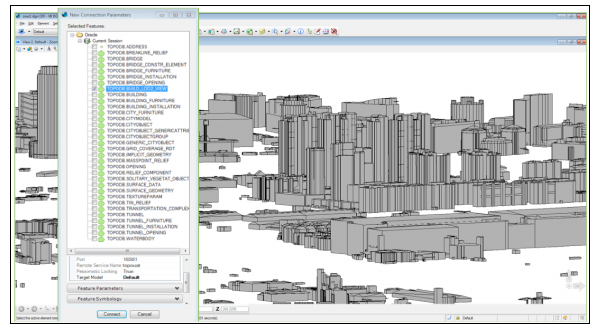
Figure 13. Connection to 3D CityDB Schema with Bentley